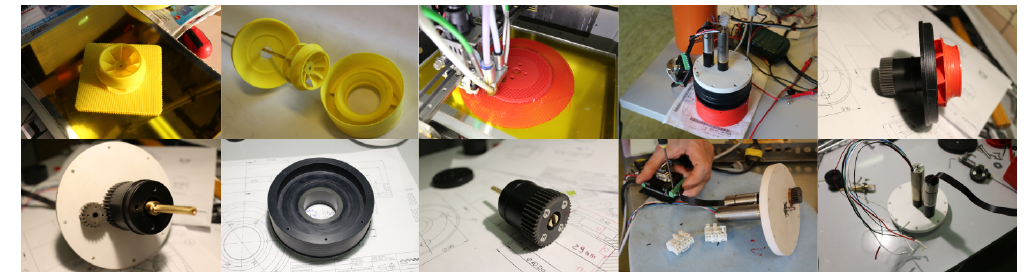
Figure 14. The manufacturing of the PJM.